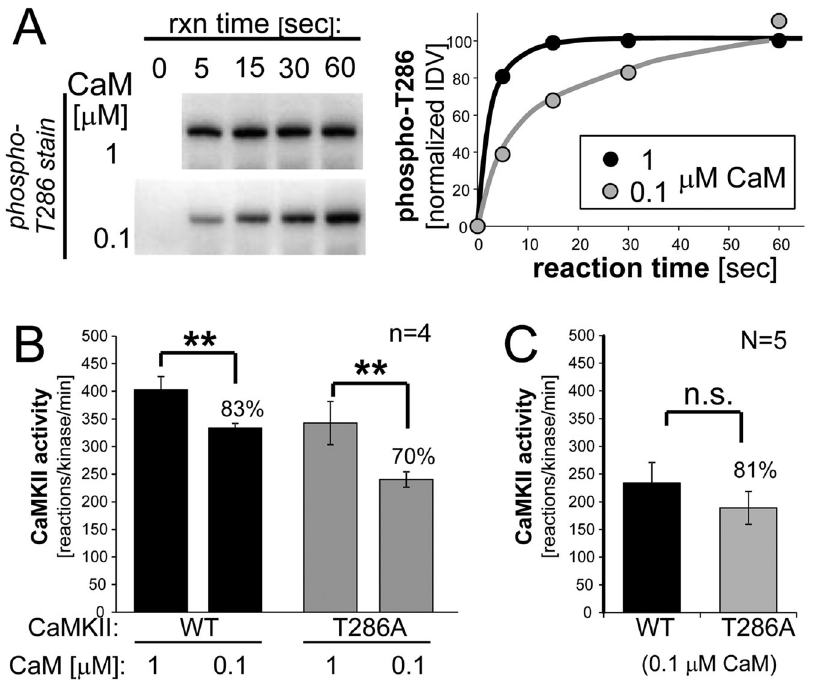
Figure 2. Submaximal stimulated activity of CaMKII wild type and its T286A mutant was induced by 0.1 m M Ca 2 + /CaM and measured by the phosphorylation rate of the substrate syntide 2 (in 1 min reactions at 30 u C). Error bars indicate mean 6 s.e.m; **: p , 0.01, n.s.: p . 0.05 in two-tailed t-test. A , T286 autophosphorylation of CaMKII wild type was assessed by Western analysis (left), and quantified by arbitrary relative immuno-detection values (IDV; right). T286 autophosphorylation stimulated by 0.1 m M Ca 2 + /CaM was slower compared to stimulation by 1 m M Ca 2 + /CaM, but the same level of maximal autophosphorylation was still achieved within 1 min reaction time at 30 u C. B , Submaximal activation by 0.1 m M Ca 2 + /CaM was verified by comparing one individual preparation of each CaMKII wild type and T286A mutant to the activity induced by 1 m M Ca 2 + /CaM (n=4 individual assays). C , The average activity of CaMKII from multiple preparations (N=5) stimulated by 0.1 m M Ca 2 + /CaM did not differ significantly between CaMKII wild type and the T286A mutant. While the ratio of the mean activities of T286A over wild type was similar as observed at maximal stimulation (compare Fig. 1B,C), the variability at submaximal stimulation was greater (with standard deviations of 35–36% of the mean at submaximal stimulation compared to 13–17% at maximal stimulation for syntide 2